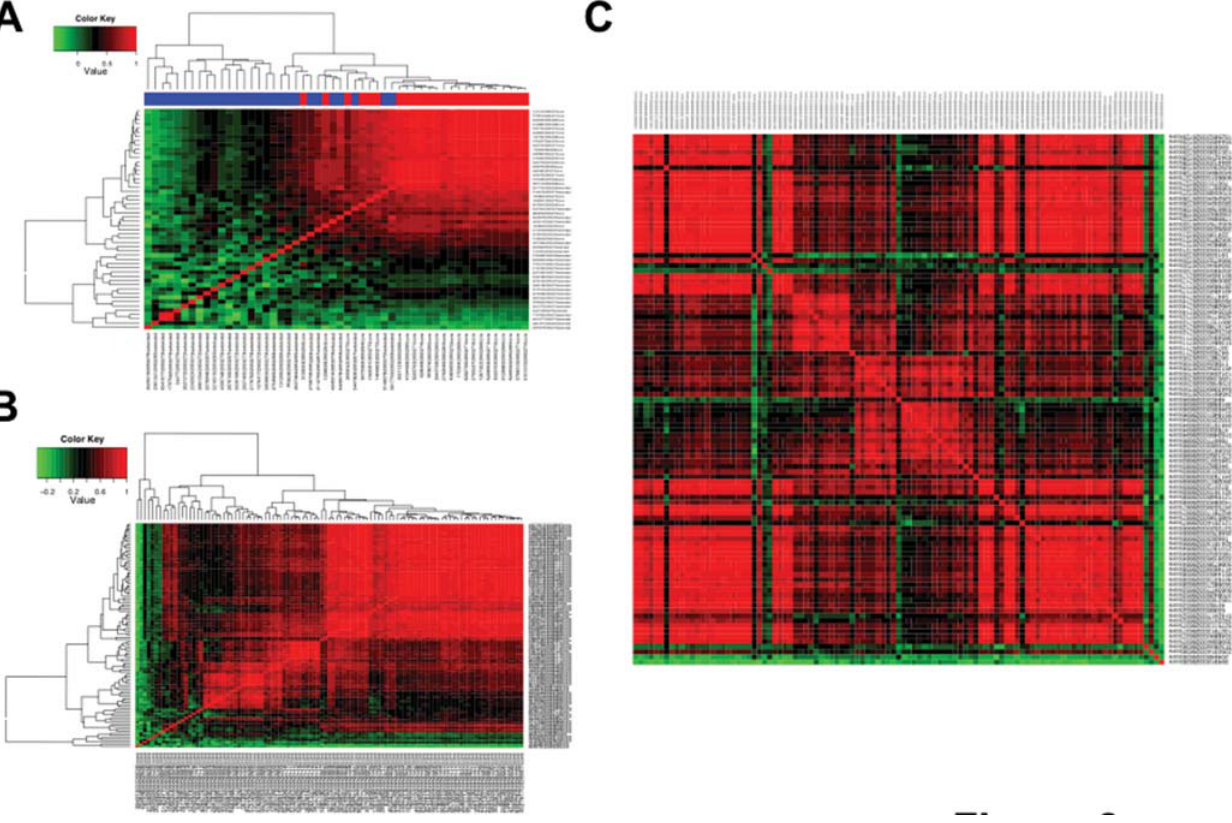
Figure 2. Heatmap visualization of exon array pairwise probe correlations. ( A ) Heatmap visualization of probe intensities of HLA-DMB (transcript cluster 2950263). Each cell of the heatmap shows the correlation of two probes in 11 tissues. The top color bar indicates the probe type. Core probes are colored in red. Extended probes are colored in blue. The signal intensities of core probes usually have a high correlation (the top right corner of the heatmap). ( B ) Heatmap visualization of probe intensities of core probes in CD44 (transcript cluster 3326635). Probes targeting the 5 9 and 3 9 regions (constitutive exons) of CD44 show highly correlated signals in 11 tissues (the top right corner of the heatmap). ( C ) Heatmap visualization of probe intensities of core probes in CD44 (transcript cluster 3326635). Probes are ordered from top to bottom based on their genomic coordinates (5 9 to 3 9 ).